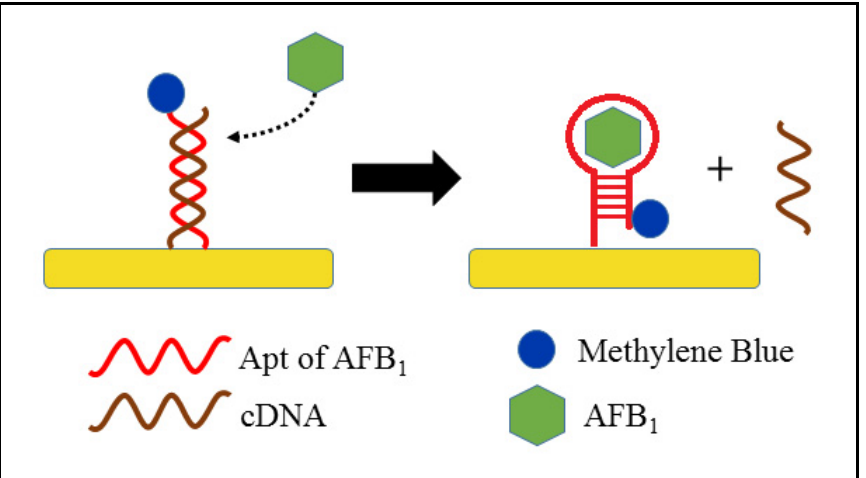
Figure 5. Schematic diagram of the AFB 1 detection mechanism by a methylene blue-tagged ap-